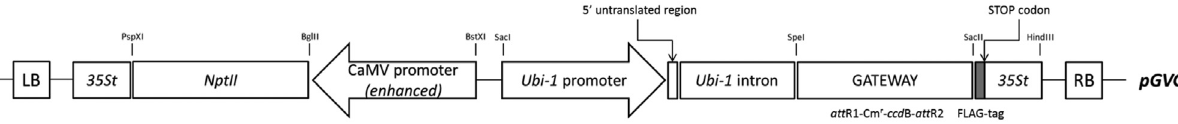
Figure 1 - Schematic structure of the pGVG vector. This vector contains the backbone from pCAMBIA2300, modified by the insertion of the ZmUbi1 promoter (including 5’ untranslated exon and first intron) for strong transgene overexpression and the CaMV 35S terminator. The sequences from the Gateway system were inserted between the ZmUBi1 promoter and the CaMV 35S terminator. A FLAG-tag was positioned upstream the terminator to fa- cilitate target protein isolation. The vector also contains the NPTII gene as plant selectable marker under control of the enhanced CaMV 35S promoter. Cm r : chloramphenicol-resistance gene. ccd B: lethal gene. RB: right border. LB: left